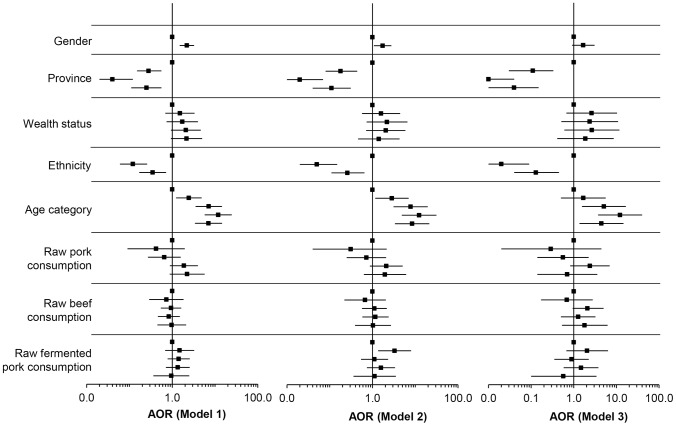
Adjusted odds ratio (AOR) of population characteristics associated with Trichinella ES ELISA reactivity, as determined by random effects multiple logistic regression modeling controlling for household clustering.All models adjusted for gender, province, wealth, ethnicity, age, frequency of raw pork consumption, raw beef consumption and fermented pork sausage consumption. Model 1; Diagnostic cut-off in Trichinella ES ELISA  =  standardised ratio ≥1.0; Model 2, Diagnostic cut-off in Trichinella ES ELISA  =  standardised ratio ≥1.2; Model 3, Diagnostic cut-off in Trichinella ES ELISA  =  standardised ratio ≥1.4. In descending order population characteristics are: Gender; female (referent), male. Province; Oudomxay (referent), Luangprabang, Huaphan, Xiengkhuang. Wealth status; most poor (referent), very poor, poor, less poor, least poor. Ethnicity; Lao-Tai (referent), Mon-Khmer, Hmong-Mien. Age category; 6–11 years (referent), 12–19 years, 20–34 years, 35–49 years, ≥50 years. Raw pork consumption; does not eat (referent), weekly, monthly, every few months, infrequent. Raw beef consumption; does not eat (referent), weekly, monthly, every few months, infrequent. Raw fermented pork consumption; does not eat (referent), weekly, monthly, every few months, infrequent (refer to data in Table S1).